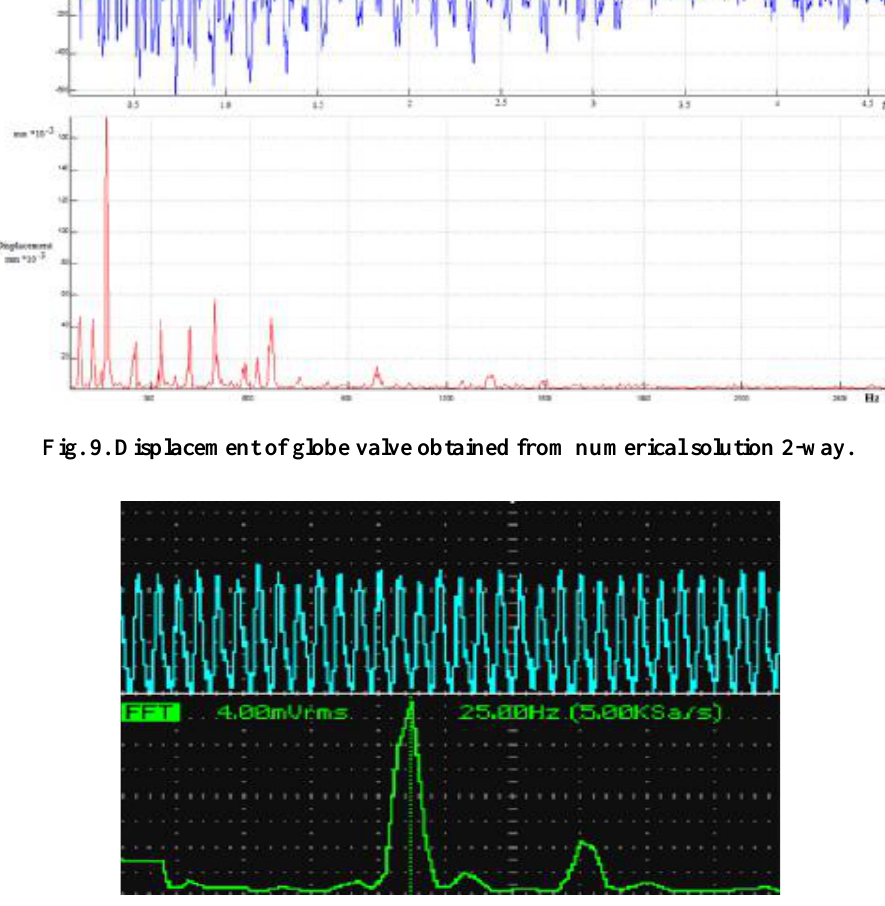
Fig. 10. Time domain and frequency spectrum (FFT) of experimental vibration signal of globe